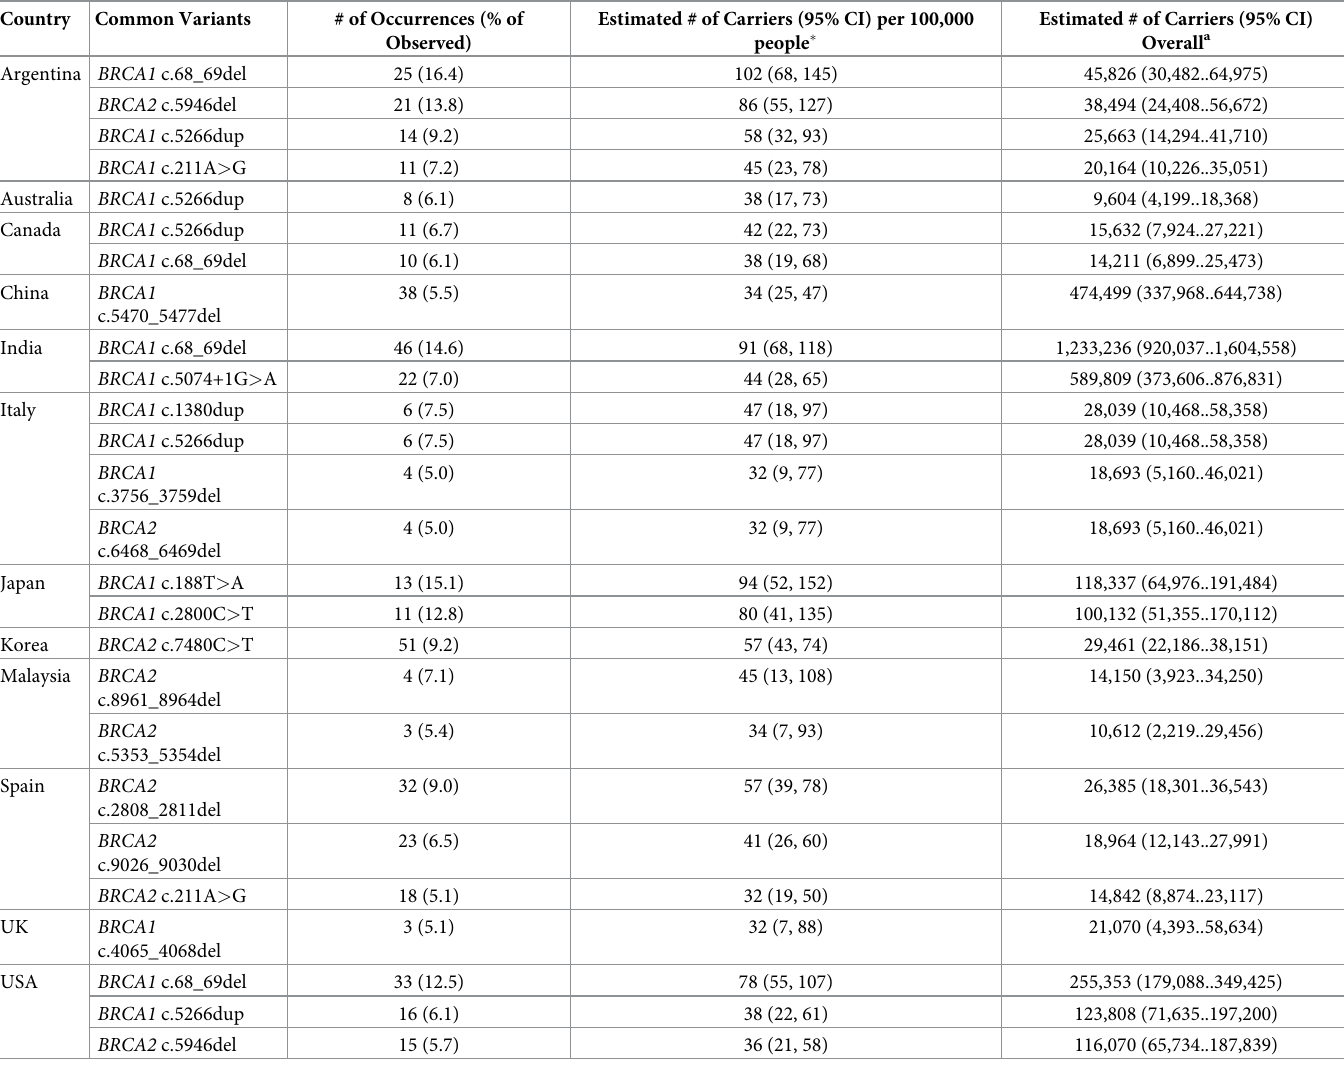
Table 4. Most common pathogenic BRCA1/2 variants in different countries. Country Common Variants # of Occurrences (% of